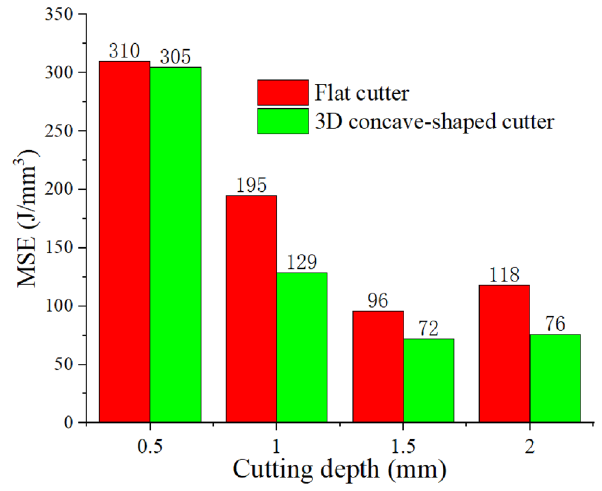
Fig. 13 Variation of MSE at different cutting